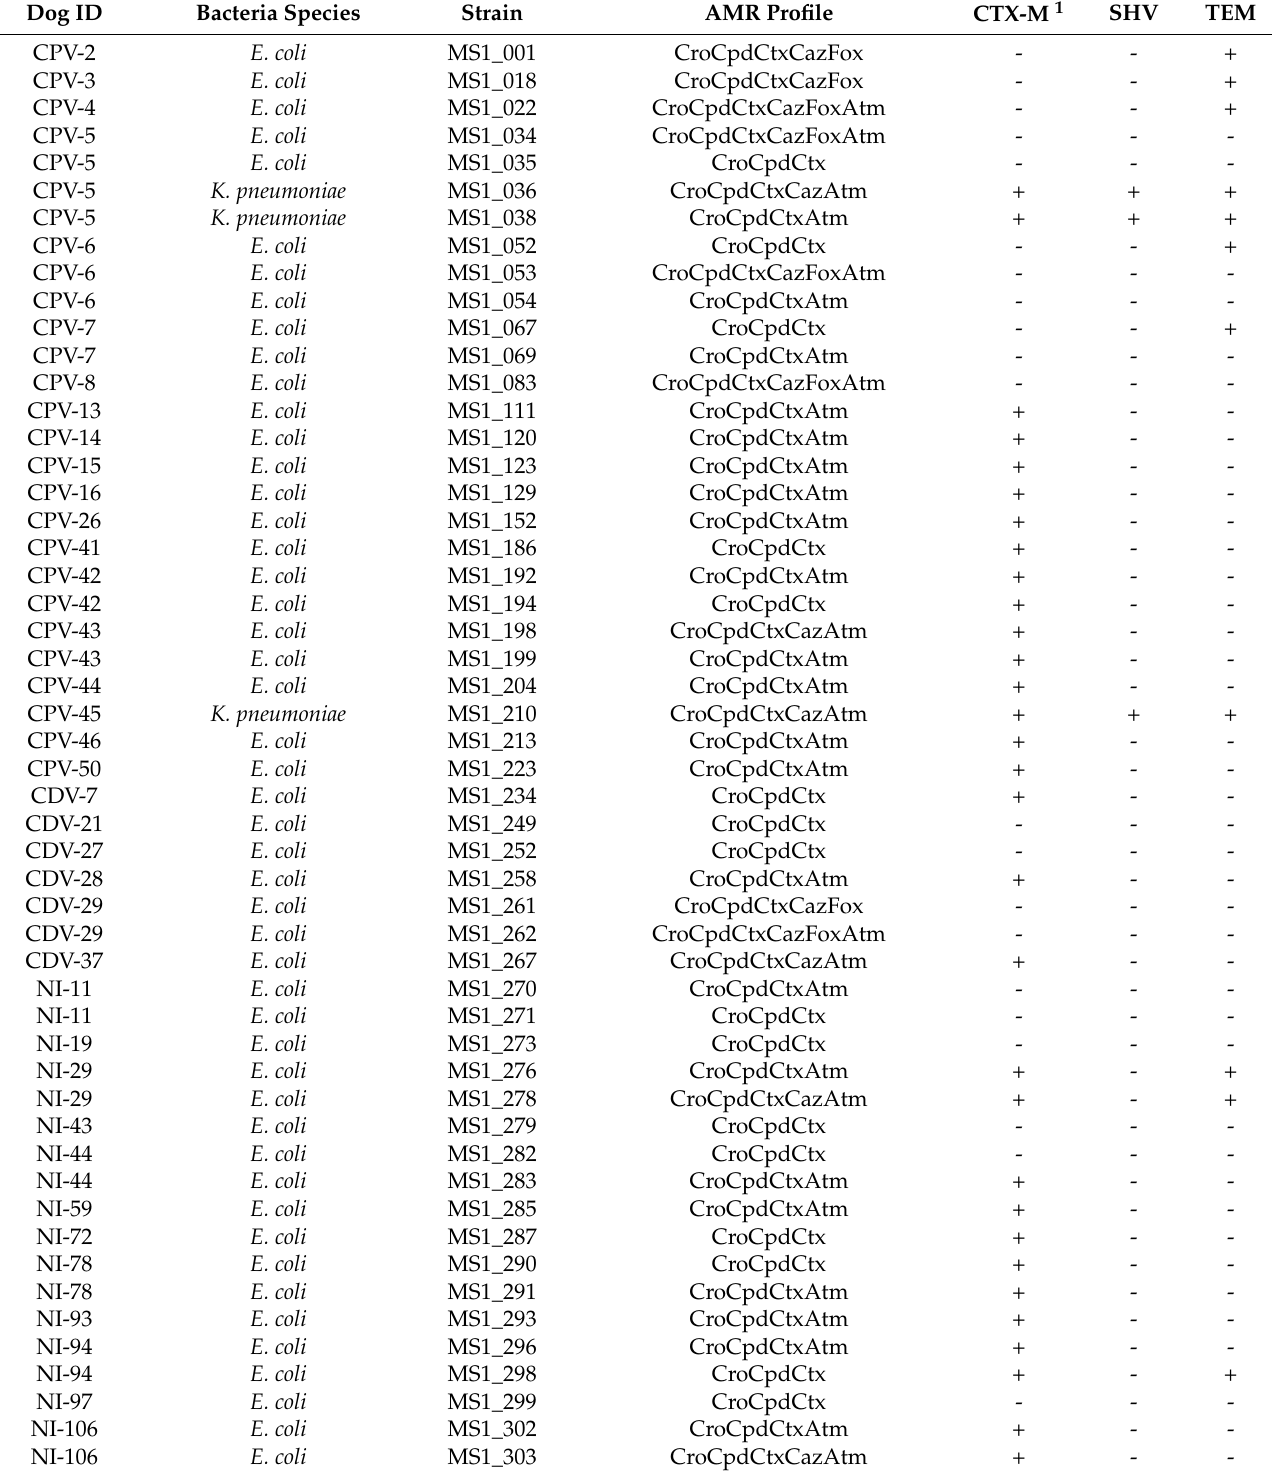
Table 2. Resistance profile and β -lactamases genes identified from ESCR- E. coli and ESCR- K. pneumoniae isolates of 19 CPV-suspected dogs, 6 CDV-suspected dogs, and 12 uninfected dogs before antibiotic